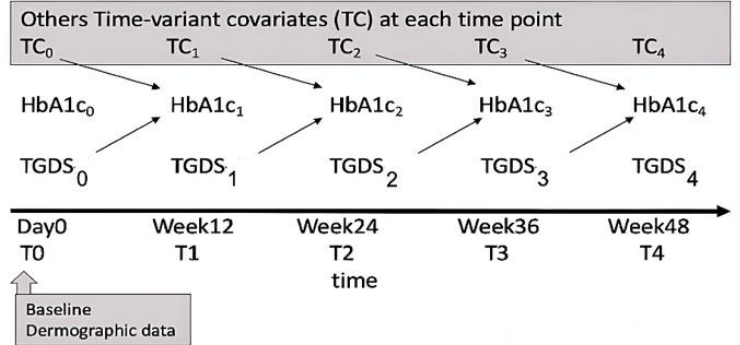
Figure 1. Schematic of data collection demonstrates that from time 0 to time 4, the variables were repeated measure at 12-week duration 5 times. The individual differences of TGDS and TC at each occasion from time 0 to time 3 were related to individual differences of HbA1c in the latter occasion or the next visit.